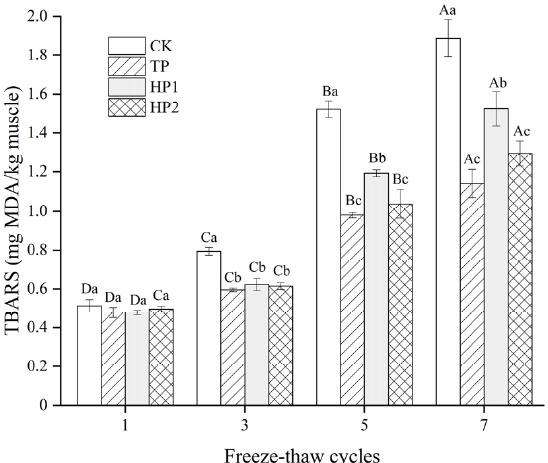
Figure 6. Changes in TBARS of freeze-thawed fish fillets: CK: fillets in distilled water; TP: fillets in tea polyphenol; HP1: fillets in 1% bone hydrolysates; HP2: fillets in 2% bone hydrolysates. Different capital letters indicate that the results of the same treatment differ significantly in freeze–thaw cycles ( p < 0.05). Different lowercase letters indicate that the results of different treatments differ significantly in the same freeze–thaw cycle ( p < 0.05).